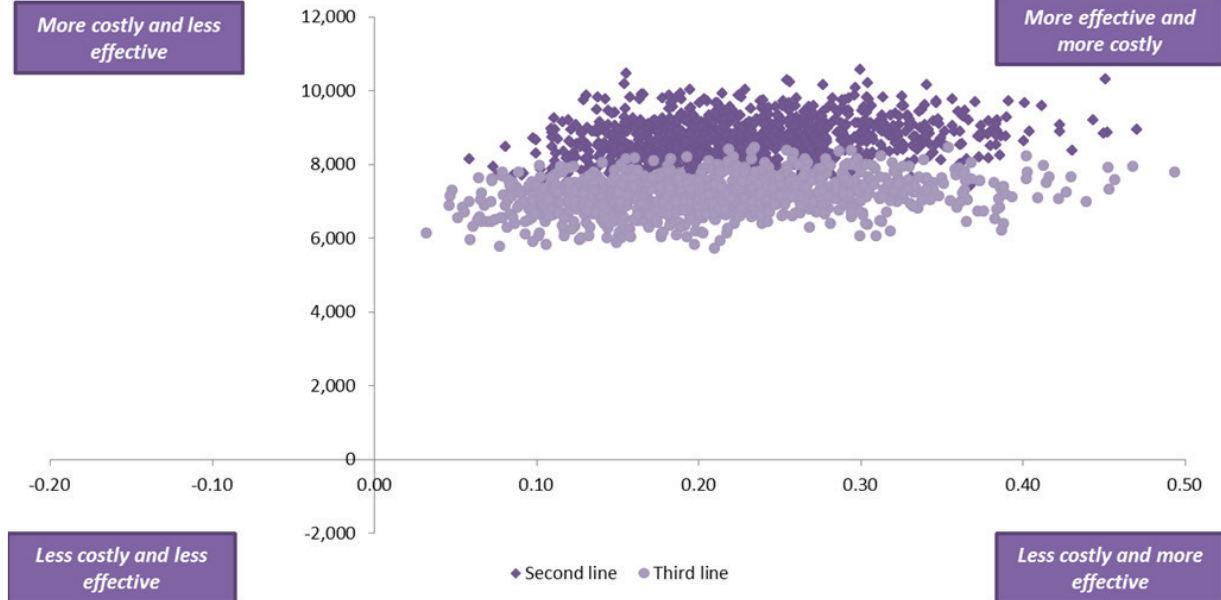
Figure 4. Cost-effectiveness Plane for Eribulin